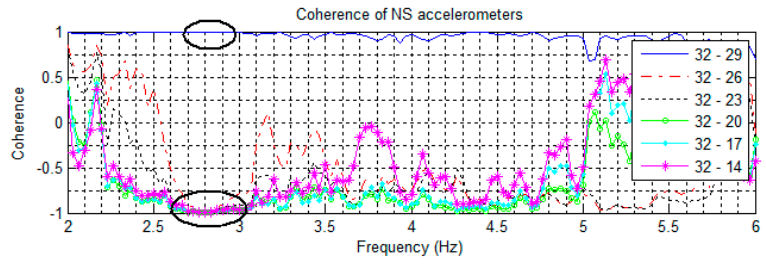
Figure 8. Coherences of NS oriented accelerometers paired against the floor 19 sensor. Note coherences at 2.81 Hz suggesting a cross-over point.